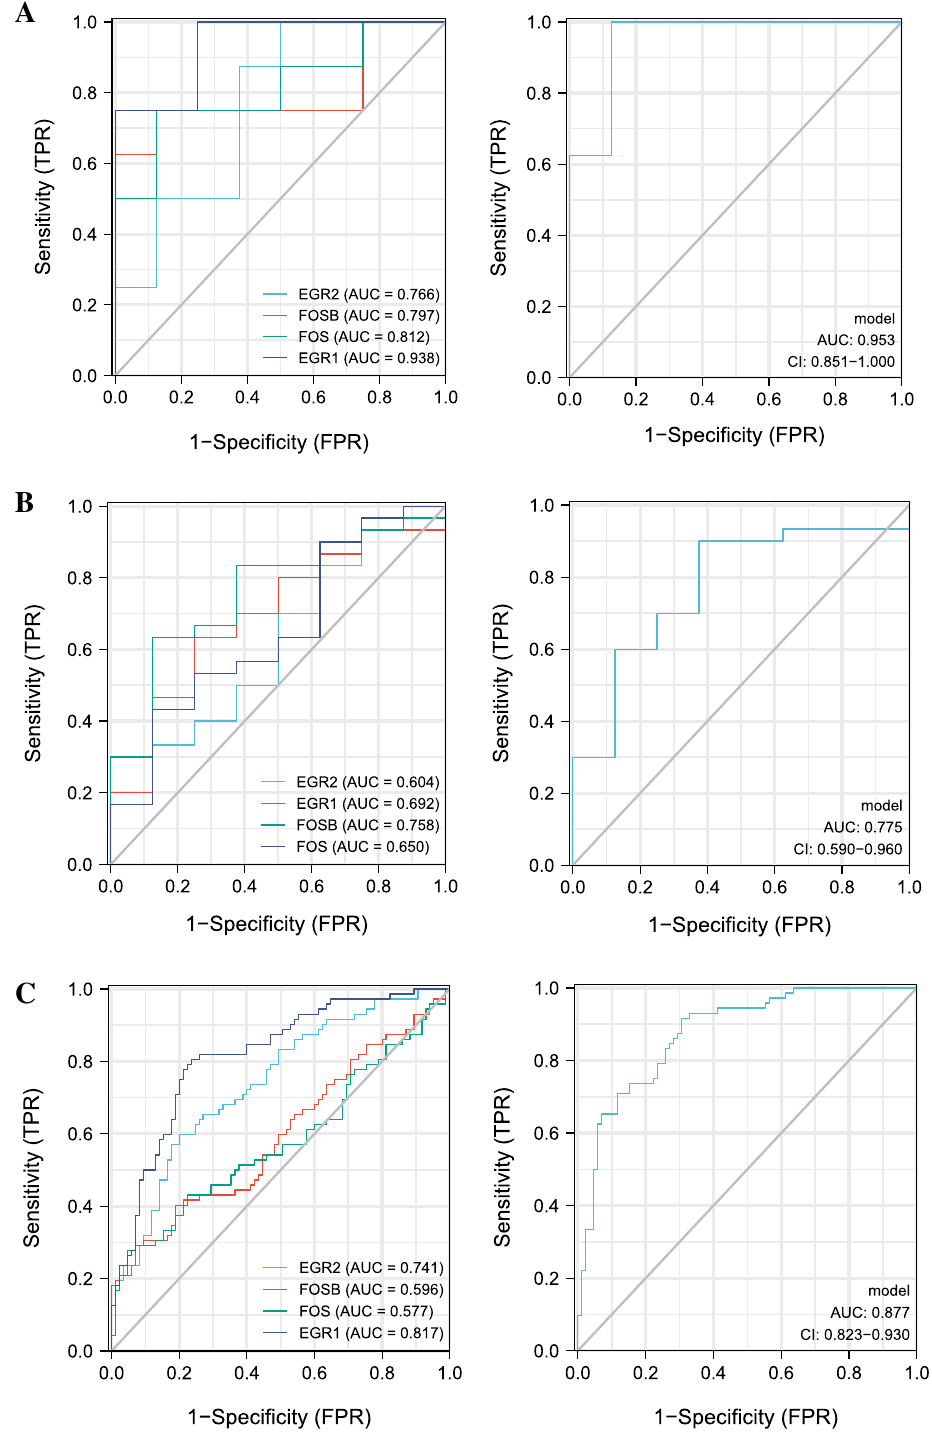
Figure 8. Analysis of the disease predictive abilities of the four selected hub genes. ( A ) ROC curve analysis of diagnostic models for single and combined genes in merged dataset. ( B ) ROC curve analysis of diagnostic models for single and combined genes in GSE21610. ( C ) ROC curve analysis of diagnostic models for single and combined genes in